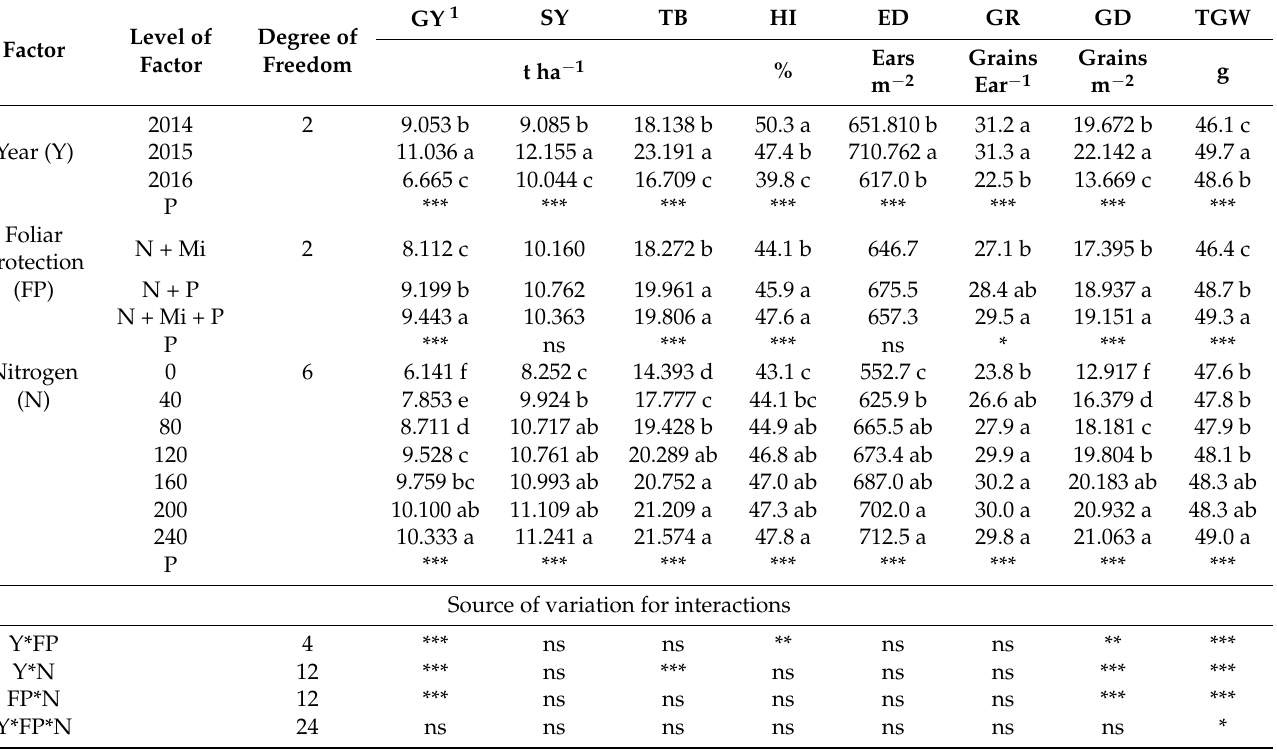
Table 4. Statistical evaluation of factors affecting yields of winter wheat and components of yield